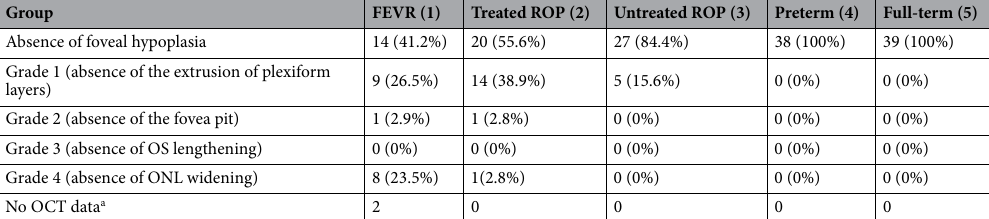
Table 3. Foveal hypoplasia in each group. FEVR: familial exudative vitreoretinopathy; ROP: retinopathy of prematurity; OS: outer segment; ONL: outer nuclear layer; OCT: optical coherence tomography. p value: < 0.001. a OCT scans that could not be judged by ophthalmologists.